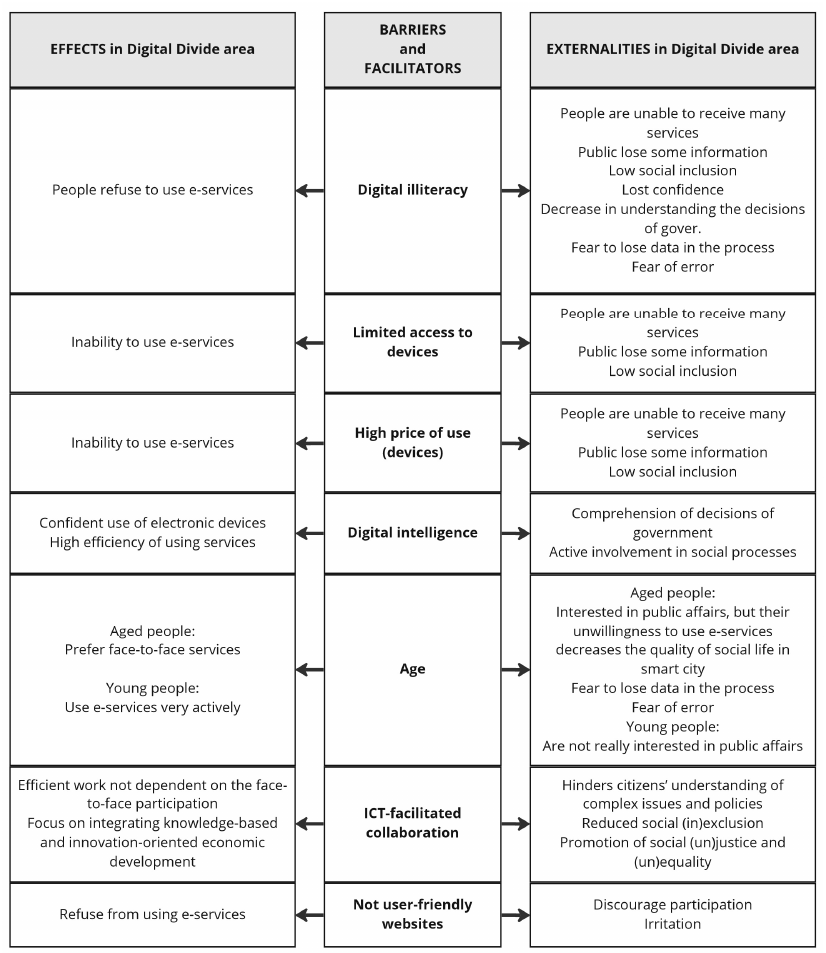
part, the effects are in the left column, and externalities are in the right column.